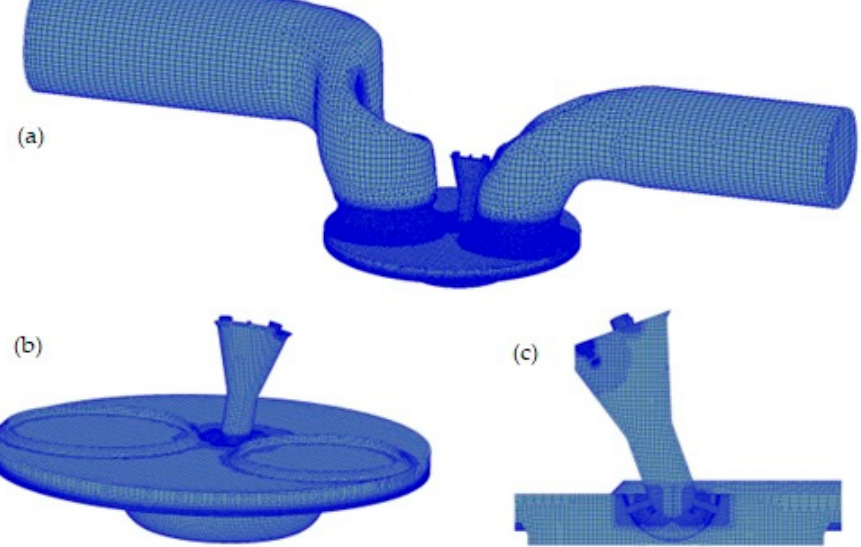
Figure 4. Computational mesh of the experimental engine with a pre-chamber, ( a ) during valve overlap at TDC, ( b ) and at FTDC. ( c ) Cross section of the pre-chamber. The discretization of the domain was performed by the FameHexa mesher using the size of 2.8 mm, along with the manually defined local refinements. The auto refinement essary, the valve gap region during the valve opening/closing period. The resulting cell